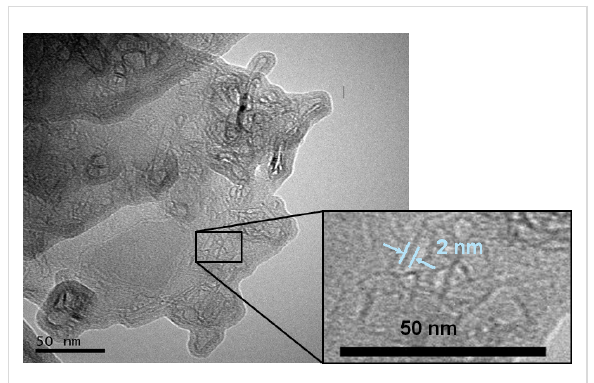
Figure 8: TEM image of DDPO 4 -imogolite. Reprinted with permission from W. Ma et al., Chem. Lett. 2011, 40, 159–161 [33]. © 2011, The Chemical Society of Japan.